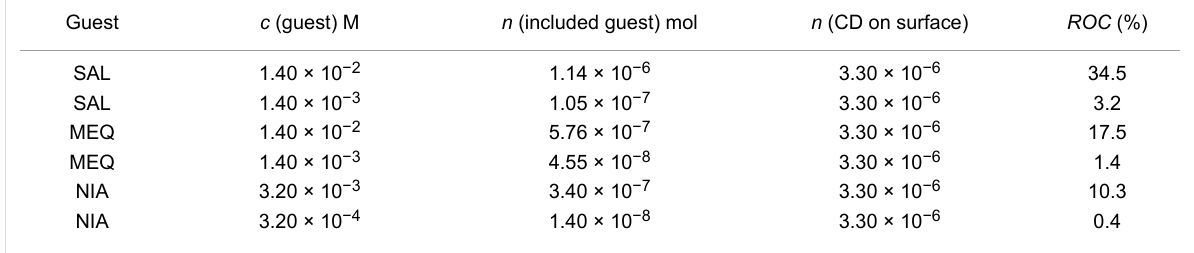
Table 1: Results of the inclusion of different guests on the Nafion ® 117 and PEMPDA- β -CD ionic assembly at neutral pH.